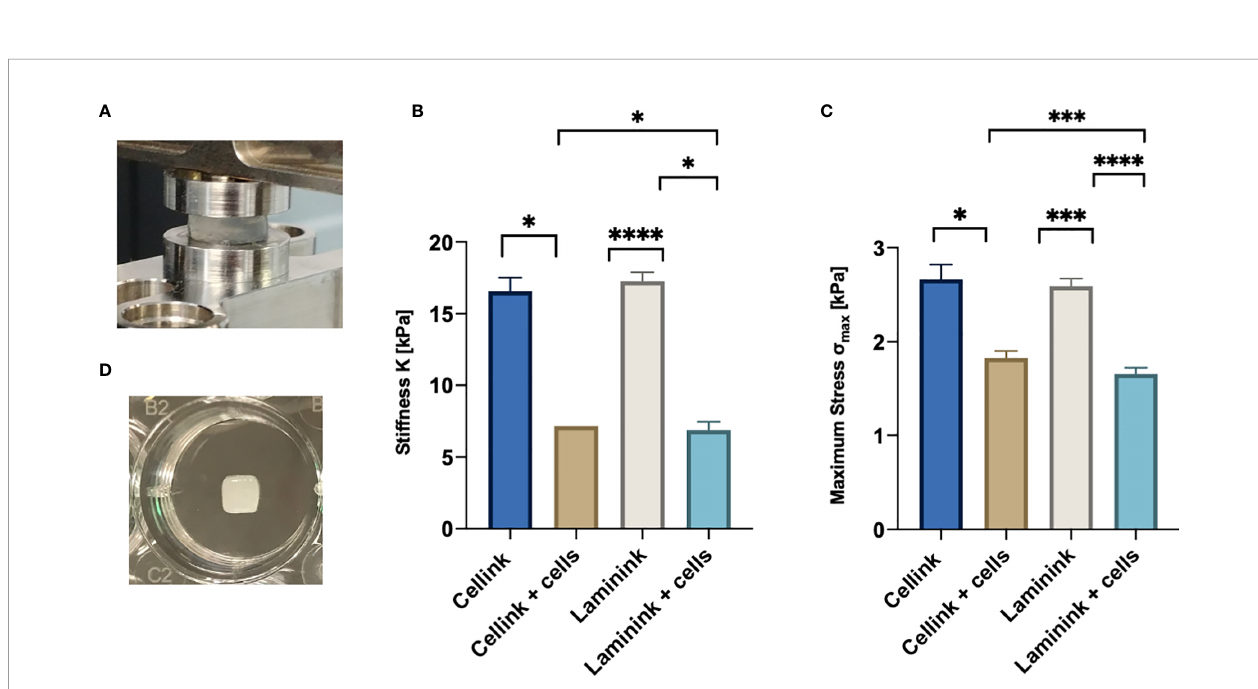
FIGURE 2 | Compressive mechanical properties of hydrogel scaffolds with and without embedded cells. (A) Hydrogel scaffold specimen in the compression mode clamps. (B) Average and standard deviation values of stiffness, K, for the scaffolds (n=4). (C) Average and standard deviation values of maximum stress, s max (n=4). (D) Representative picture of a 5x5x1mm 3 3D-bioprinted scaffold in a well of a 24-well plate. *p < 0.05, ***p < 0.001, ****p <